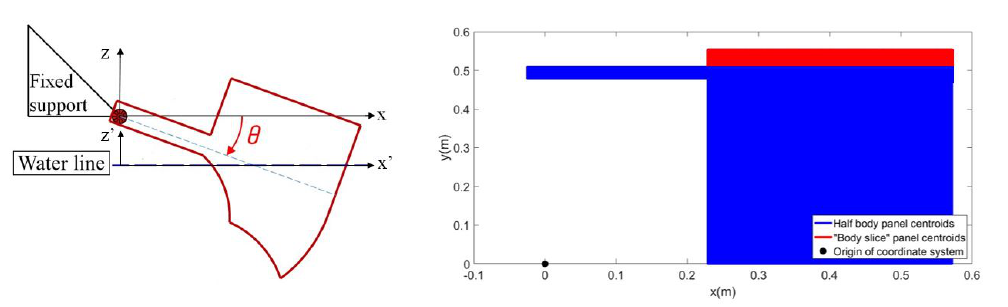
Figure 2. Left : Body coordinate system ( x , y , z ) and global coordinate system ( x (cid:48) , y (cid:48) , z (cid:48) ) of the pitching WEC. Wave propagation is in the x (cid:48) direction. Right : Top view of panel centroids of (half) WEC and selected